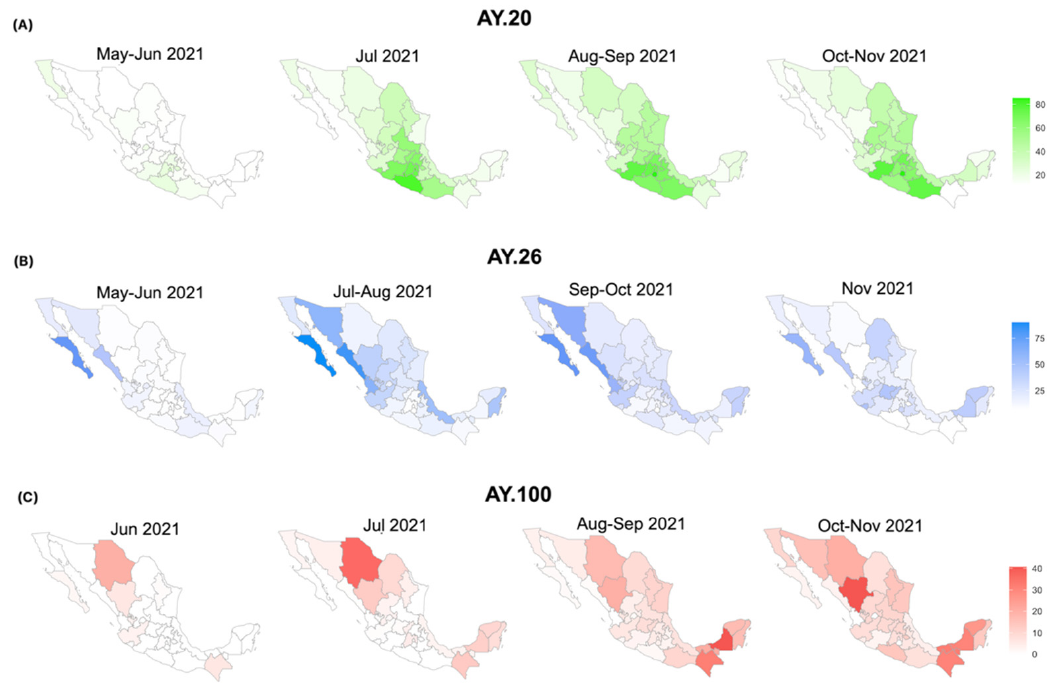
Figure 5. Map series showing the spatiotemporal distribution of the most prevalent Delta sublineages in Mexico. ( A ) Sublineage AY.20, ( B ) sublineage AY.26, ( C ) sublineage AY.100. The prevalence was calculated for each state over time.